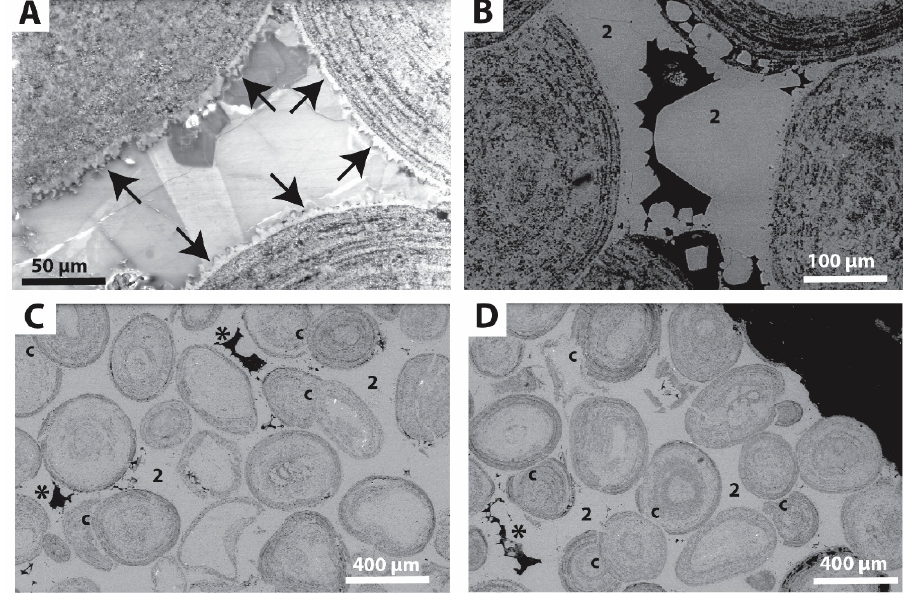
Figure 6. Scanning Electron Microscope (SEM) images of a typical Jurassic oolitic limestone, from a polished thin section. ( A ) Charge contrast image, illustrating rimming cement (arrows), and equant pore blocking cement; ( B ) backscattered (BSE) image illustrating pore blocking cement (2), and angular residual pores (black); ( C ) and ( D ) BSE images, with wider field of views, illustrating pore blocking cement (2), angular residual pores (*) and compacted grains (c). All images obtained in low-vacuum mode using an FEI Quanta FEG 650 SEM.